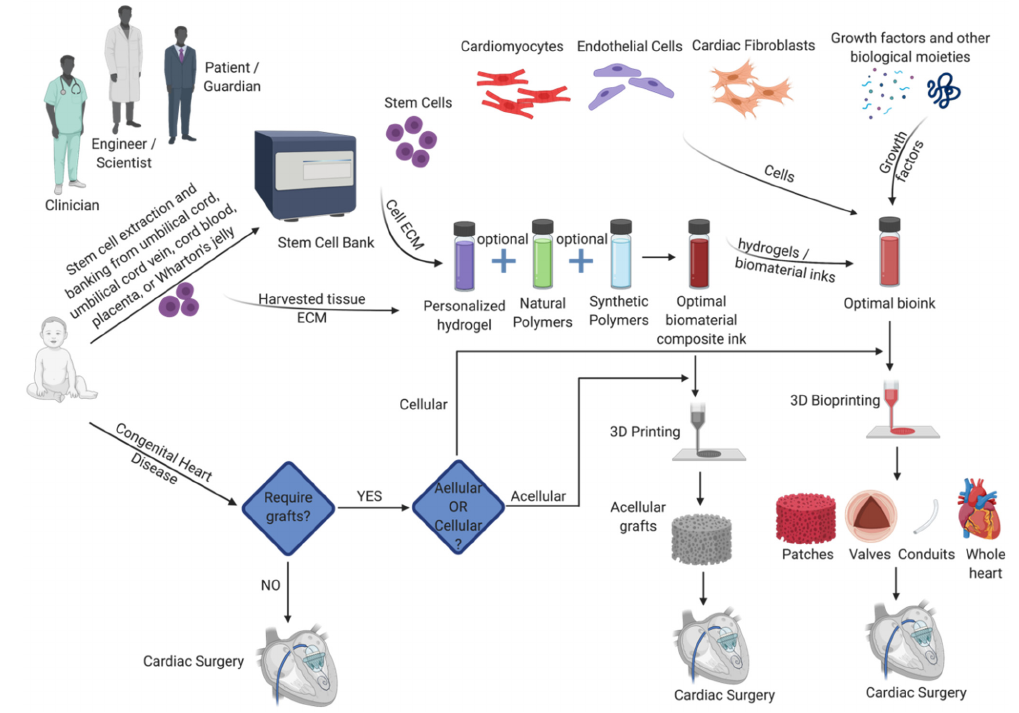
Figure 7. Process flow of biofabrication strategies for congenital cardiac surgery.